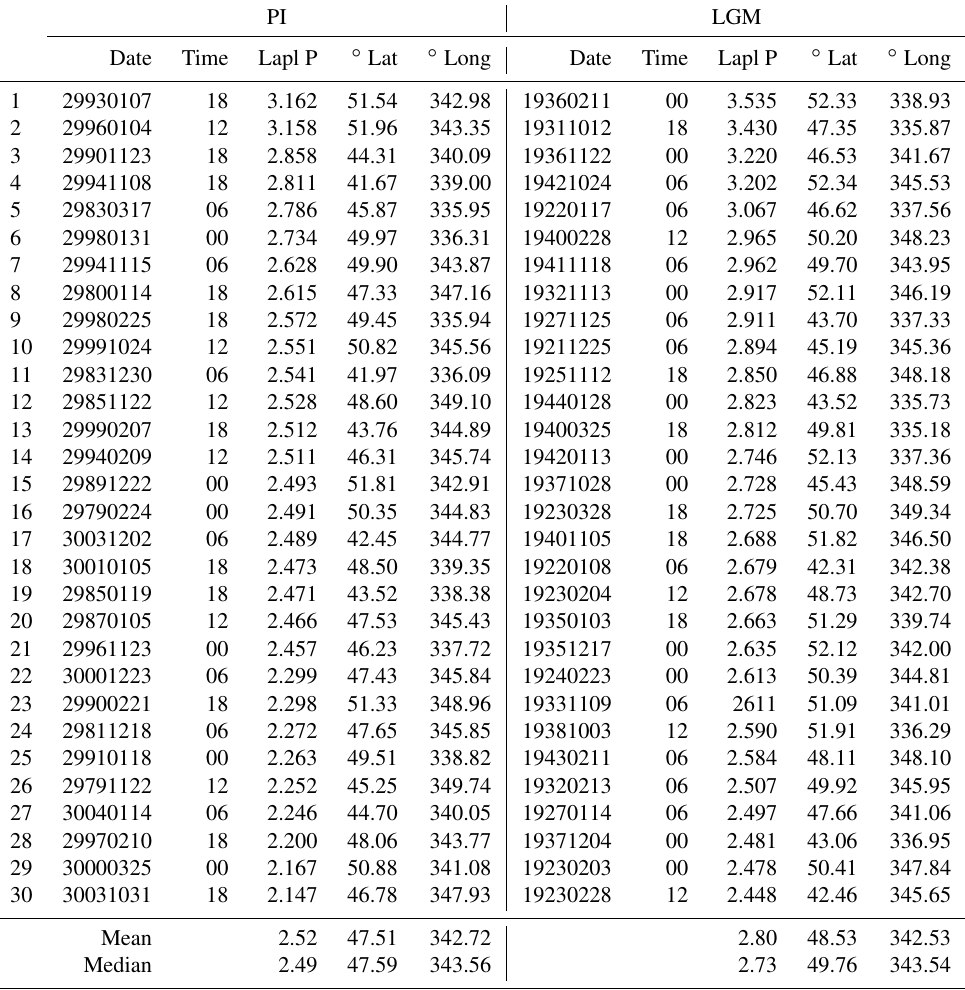
Table 3. Overview of time and location of maximum intensity (defined by the maximum of the Laplacian of MSLP) of the top 30 MPI-ESM-P cyclones for PI and LGM conditions inside the box (Fig.